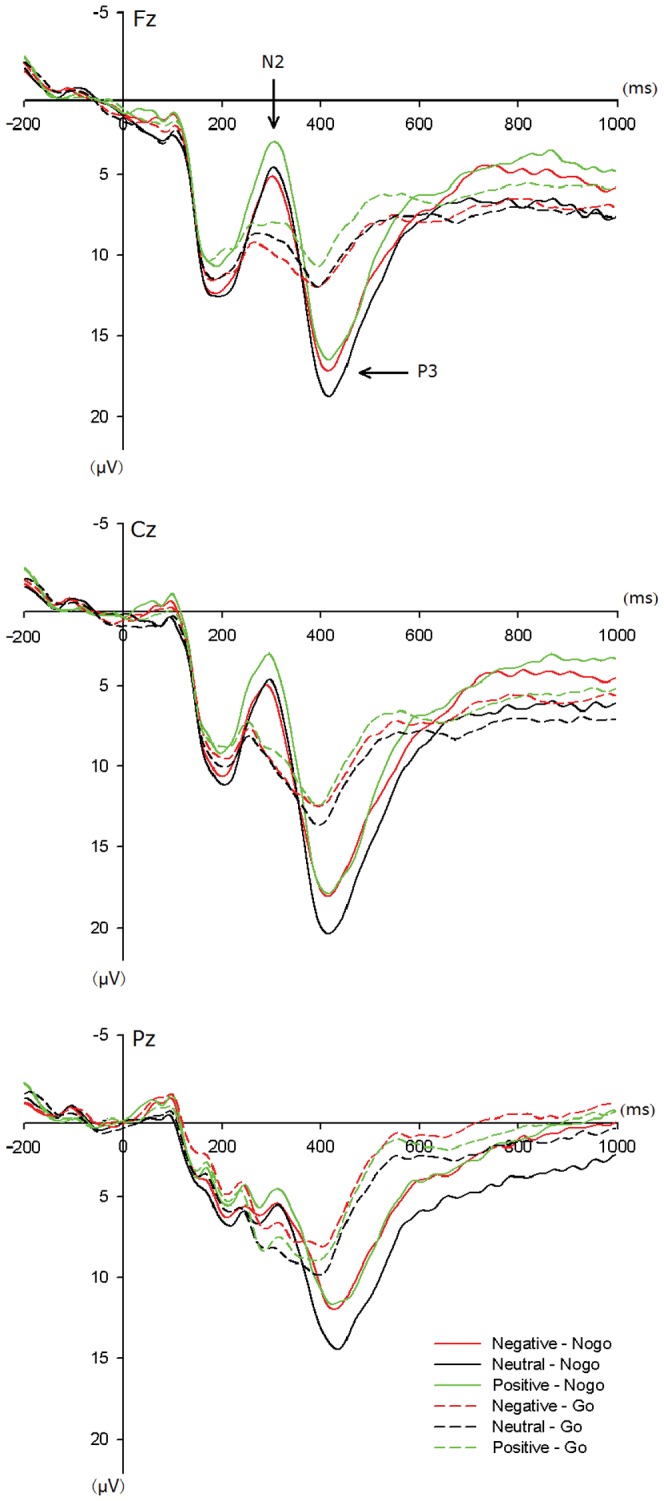
The averaged ERP evoked by Nogo (solid lines) and Go (dashed lines) stimuli during negative (red lines), neutral (black lines) and positive (green lines) emotional conditions at Fz, Cz and Pz.